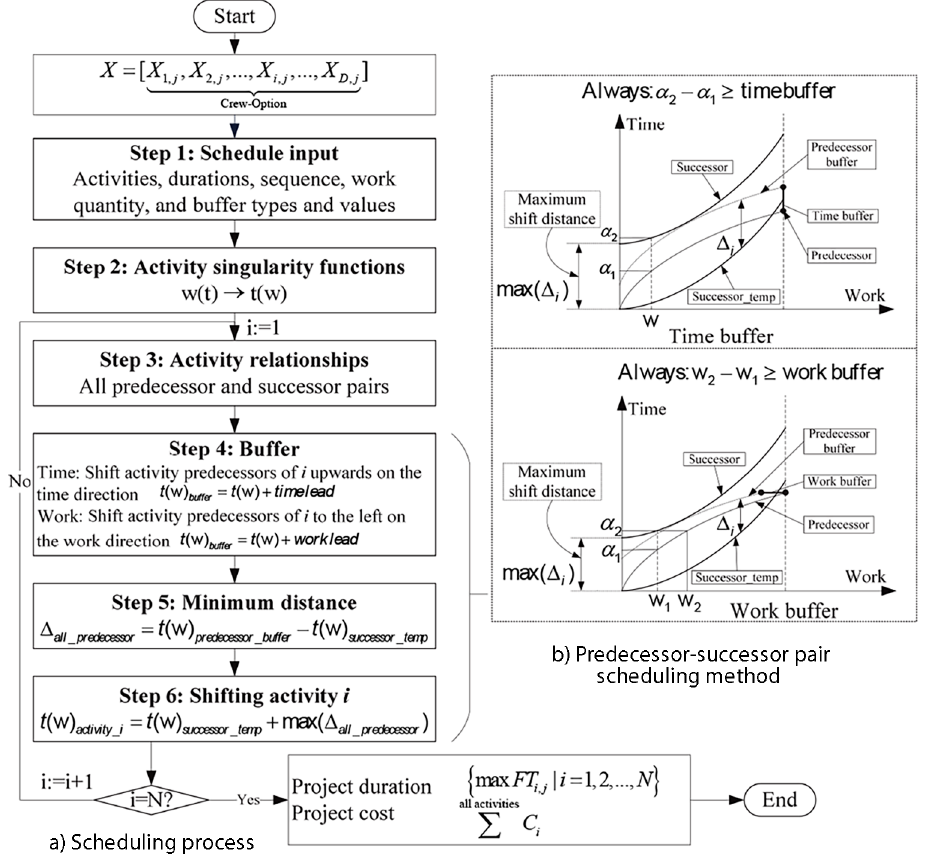
Figure 4. Scheduling